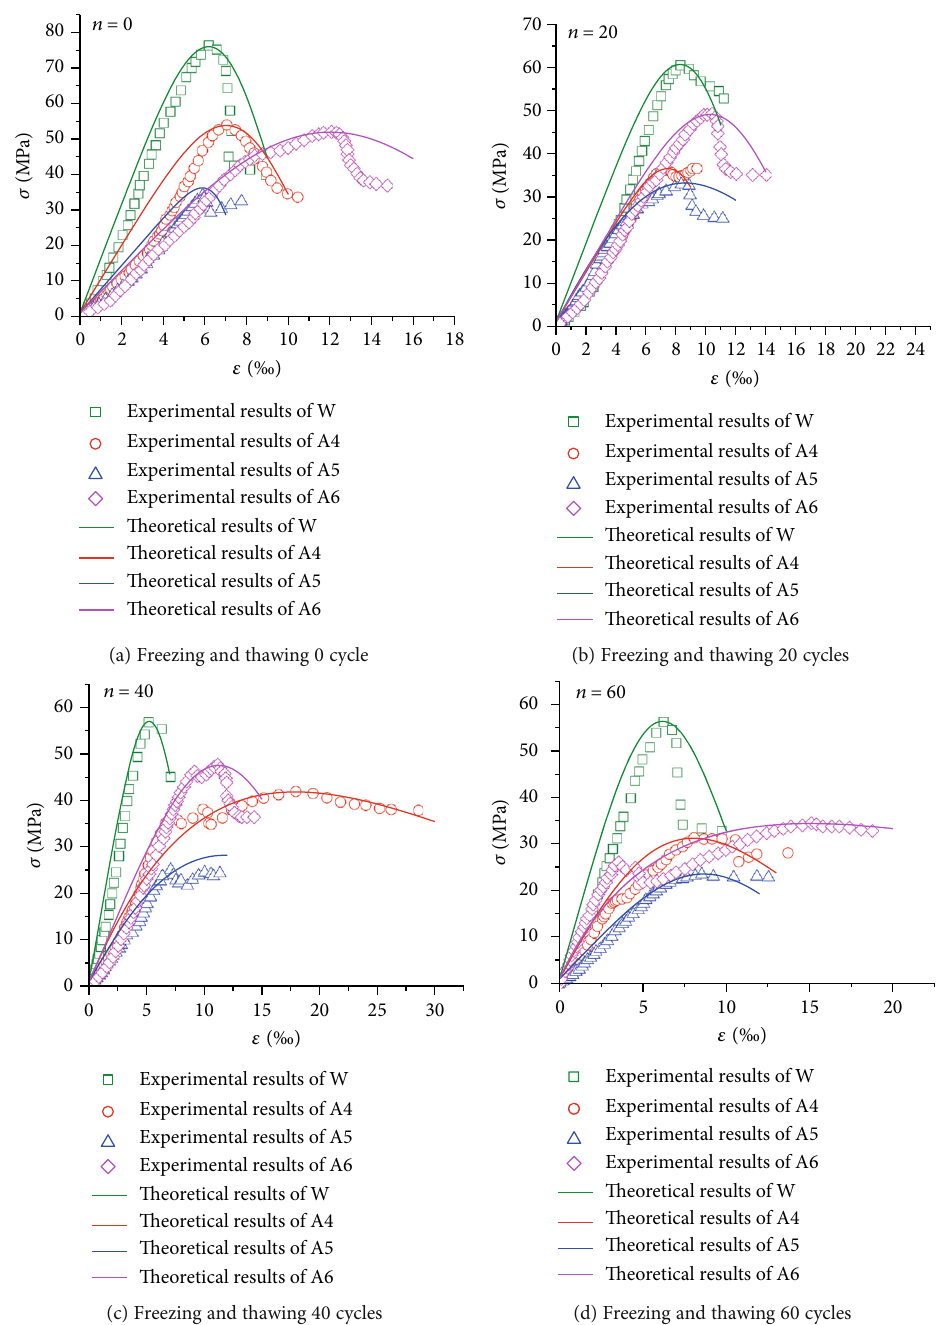
Figure 6: The conventional triaxial compression experimental data of rocks con fi ned by 4 MPa under freezing and thawing cycle